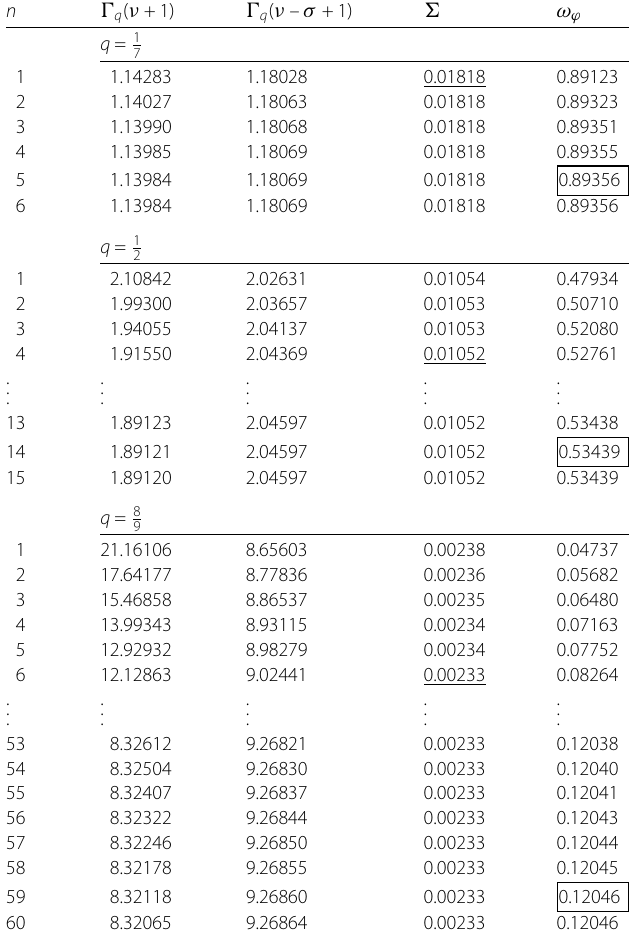
˘ (cid:21) for q = 1 in Example 5.1 7